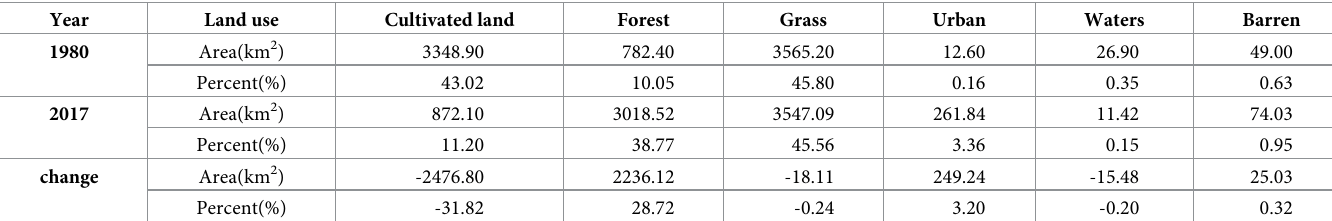
Table 1. Land uses in the Yanhe River Basin in 1980 and 2017.